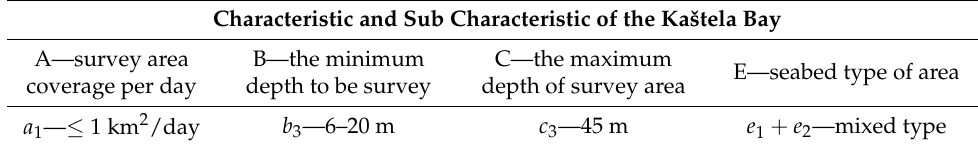
Table 5. Characteristic and sub characteristic of the hydrographic survey area.